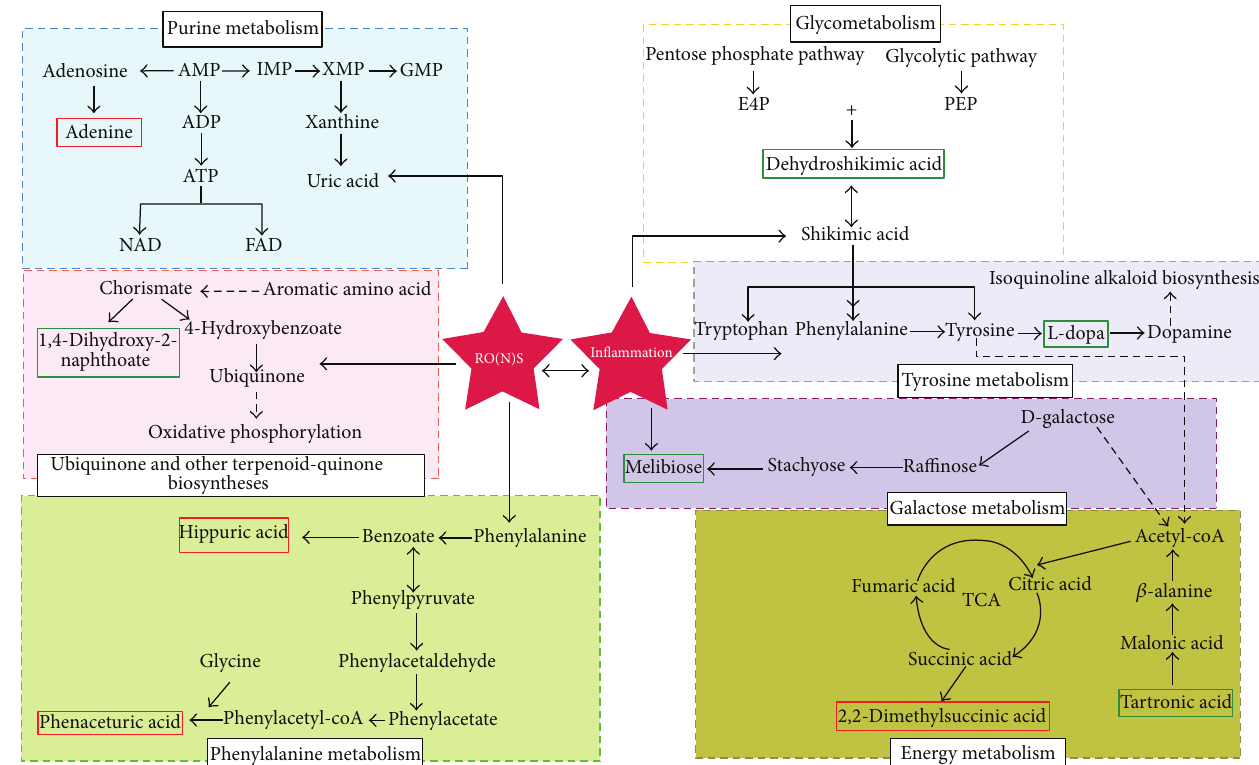
Figure 8: Correlation networks of all the potential biomarkers in response to RA. Nine potential biomarkers were used to explain the possible metabolic pathways. Metabolites with red box were significantly increased in untreated group compared to healthy group. Metabolites with blue box were significantly decreased in untreated group compared to healthy